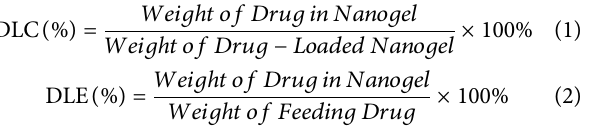
Frontiers in Bioengineering and Biotechnology |